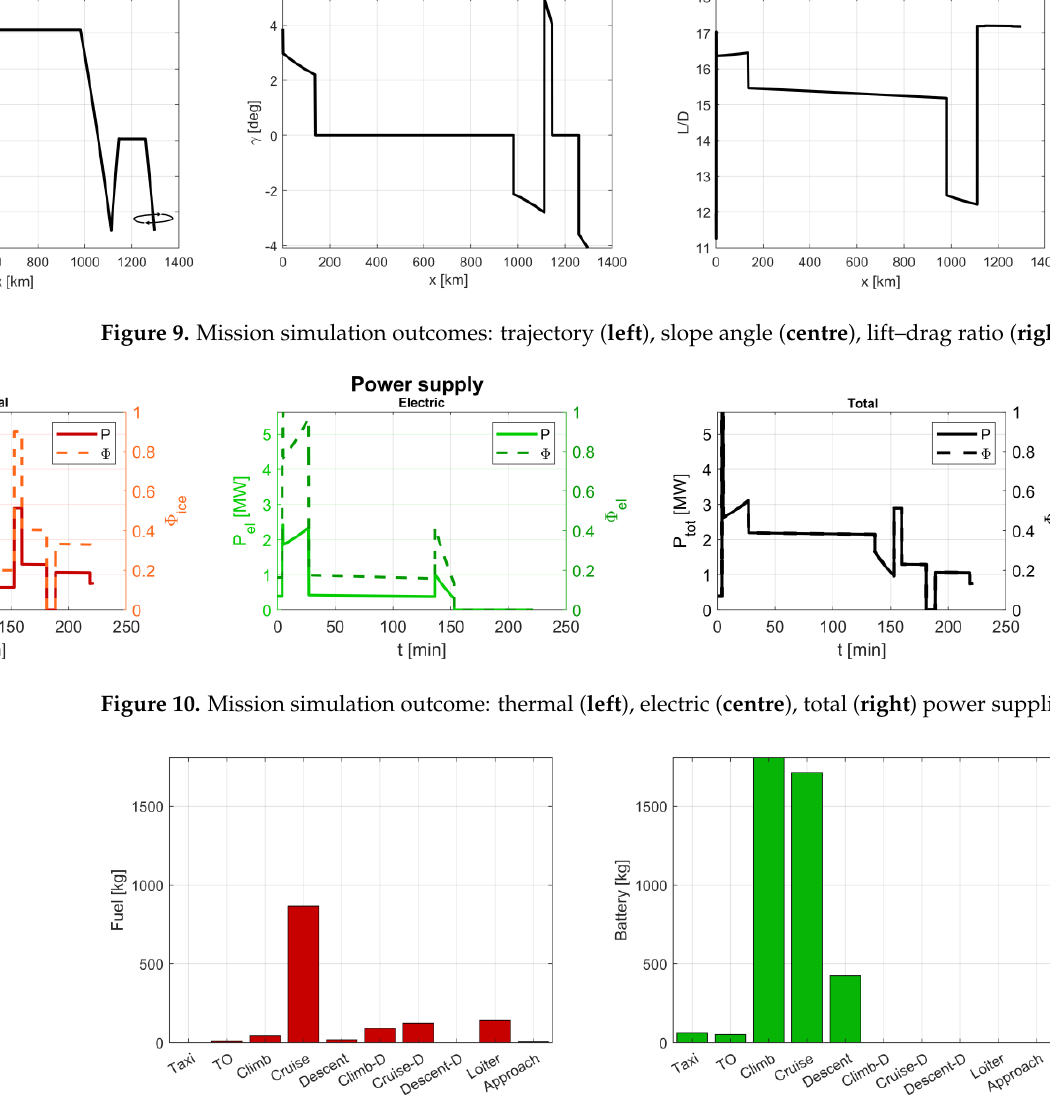
Figure 11. Mission simulation outcome: fuel (left) and battery (right) mass breakdown.